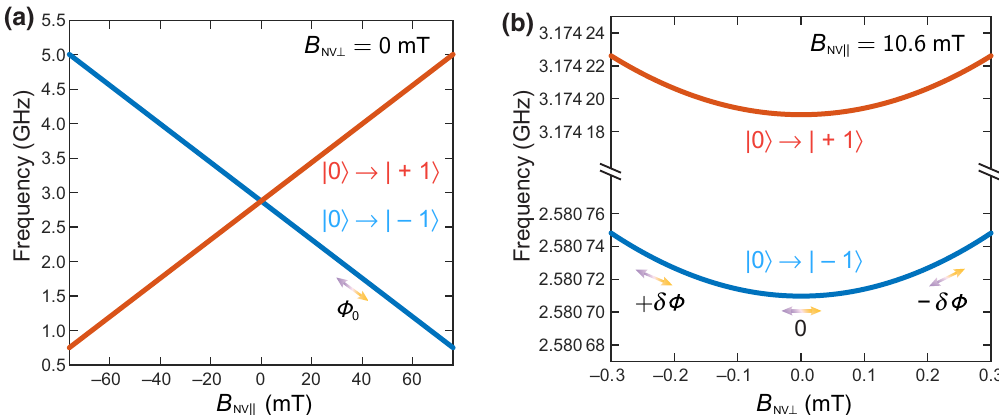
FIG. 13. (a) NV center spin energies as a function of B NV (cid:7) , parallel to the NV axis, with zero off-axis field B NV ⊥ . The slope of the energy versus field is not field dependent. (b) NV center spin energies as a function of B NV ⊥ , perpendicular to the NV axis, with fixed B NV (cid:7) . The slope is proportional to B NV ⊥ , although it is much smaller in absolute magnitude than (a). The maximum precession angle (cid:16) NV in an XY8- N sequence is proportional to the sum of the ac field amplitude in each direction multiplied by its respective slope.